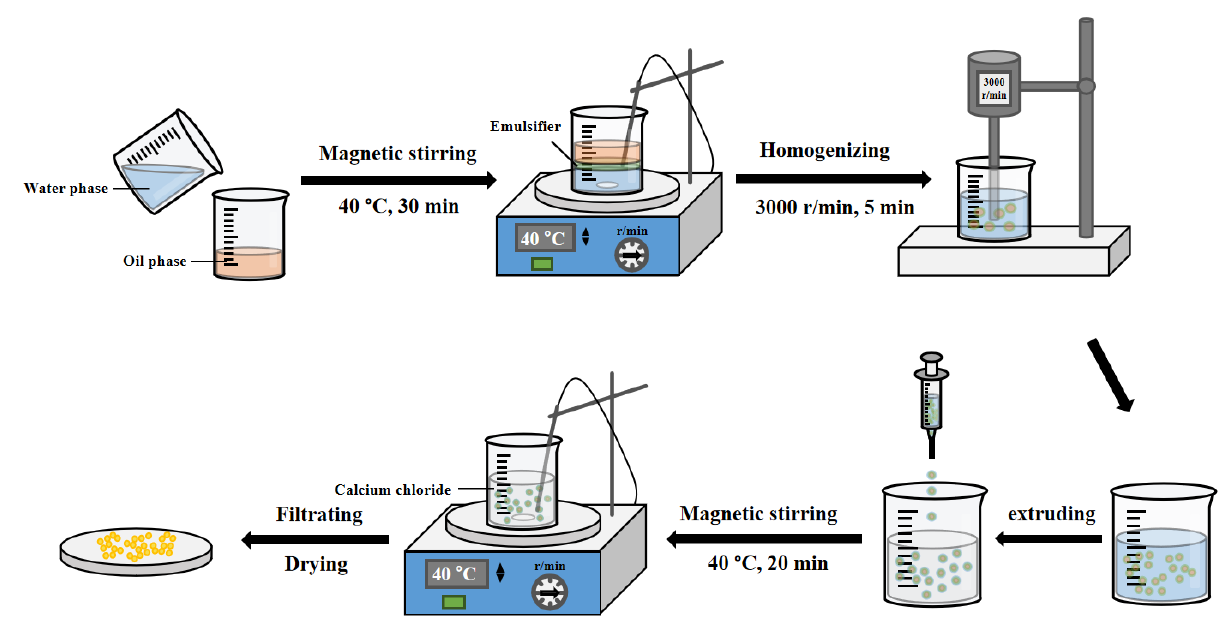
Figure 2. Schematic diagram of the production of microspheres.